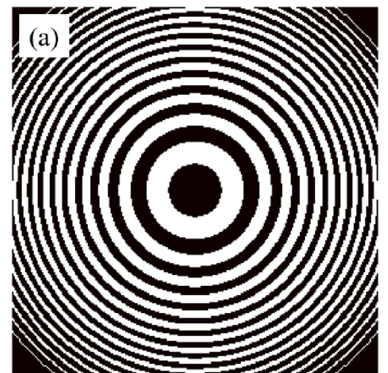
Figure 2. ( a ) Binarization and ( b ) peak fitting.